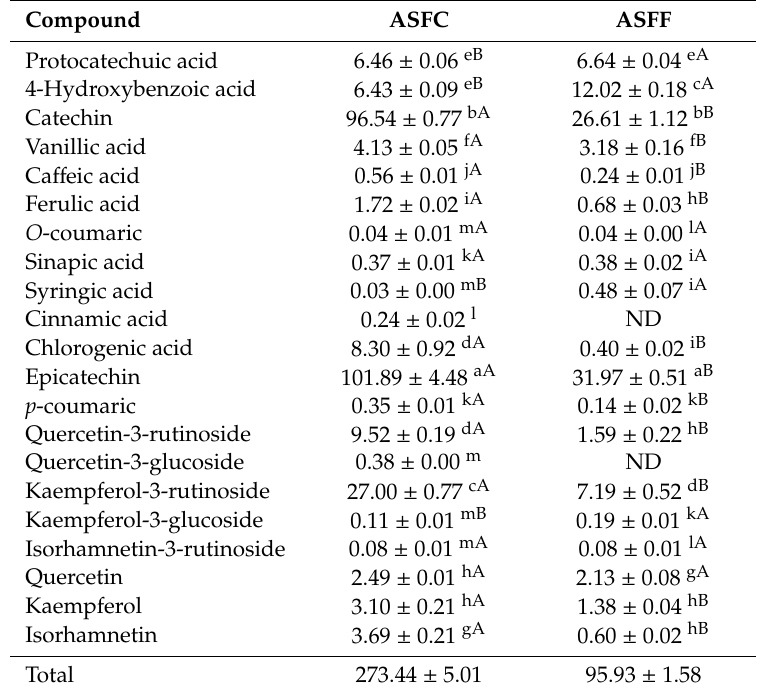
Table 4. Polyphenolic profile of almond skin flours obtained from Turr ó n coproducts. Compound ASFC ASFF Protocatechuic